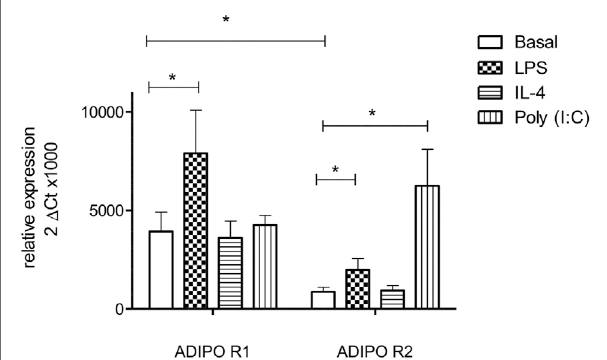
FIGURE 3 | Expression of AdipoR1 and AdipoR2 transcripts by human LMs. Human LMs were cultured for 24 h in absence or presence of LPS (10 ng ml − 1 ), poly (I:C) (10 µg ml − 1 ) or IL-4 (10 ng ml − 1 ). AdipoR1 and AdipoR2transcriptlevels were determined byRT-qPCR and normalized against those of a housekeeping gene ( HPRT1 ). Data correspond to the mean ± SEM of 6 independent experiments (*: p < 0.05).